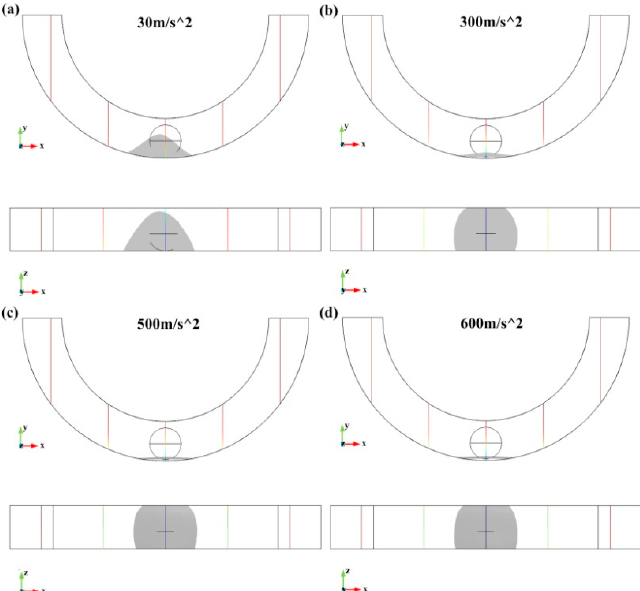
Figure 6. The deformations of the droplet at accelerations 30, 300, 500, and 600 m/s 2 , respectively.